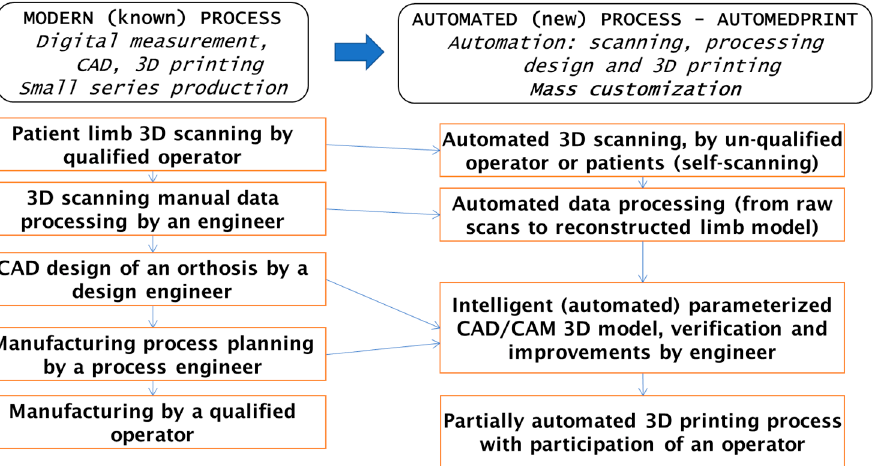
Figure 1. AutoMedPrint system: assumptions for process automation in comparison with a typical process.